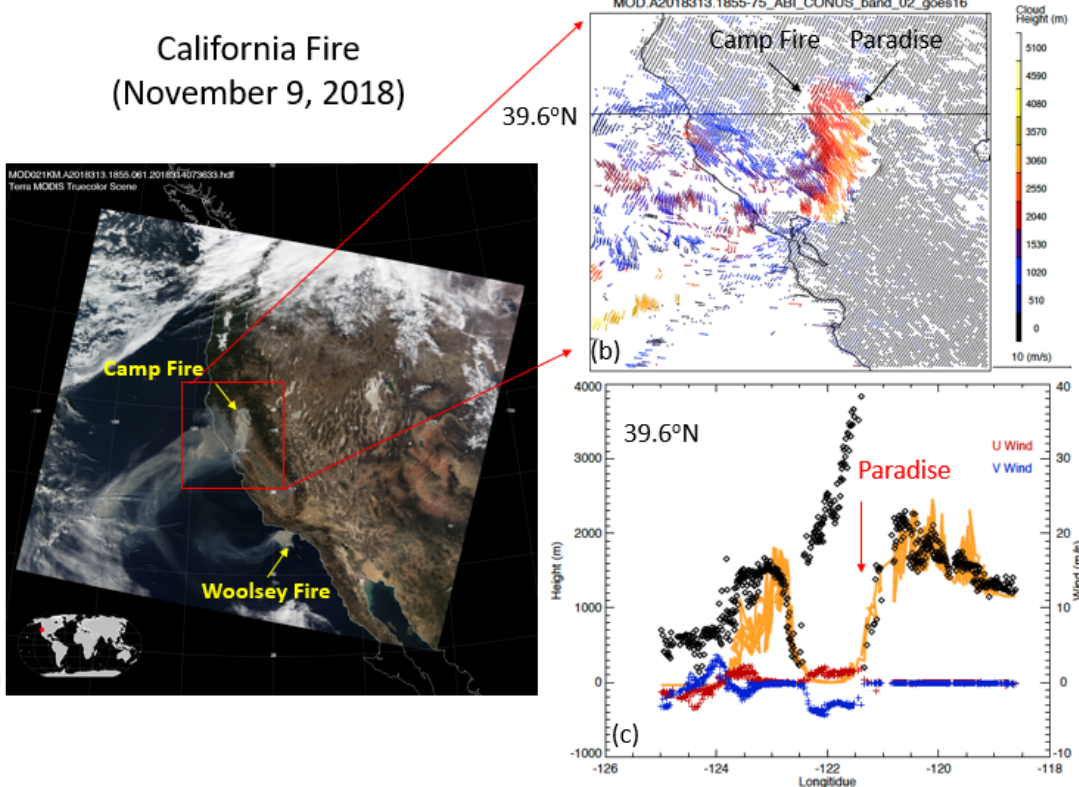
Figure 31. ( a ) California camp fire and Woolsey fire as seen by Aqua/MODIS on November 9th. ( b ) The MODIS-GOES AMV and height retrievals over the northern California, and the cross-section ( c ) at a latitude of 39.6 ° N. The AMV vectors in the map are colored by their height above terrain. In the 39.6 ° N cross section, the terrain height is in orange whereas the 3D-wind stereo height is in black.